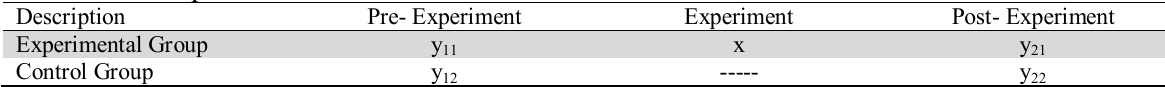
Research conceptual model Description